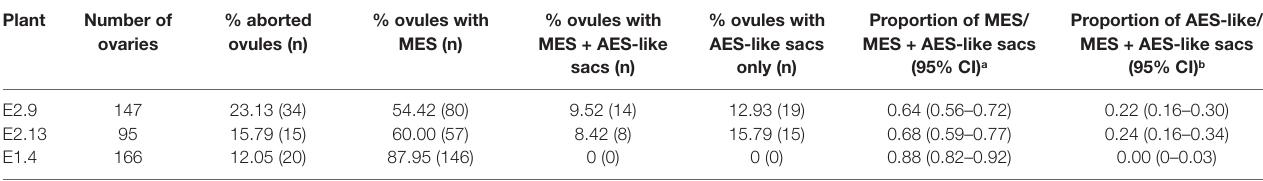
TABle 1 | Embryo sac development assessed by cytoembryological analysis in antisense and control lines at anthesis. Plant number of